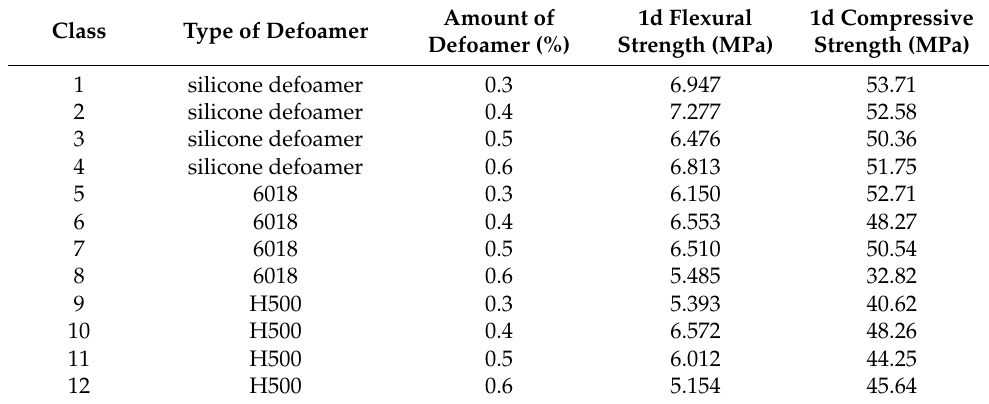
Table 9. Effect of different defoamers on strength of grouting materials.